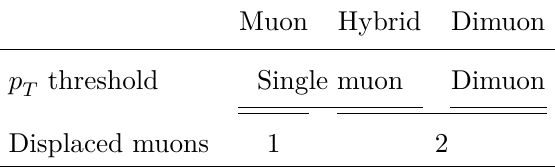
threshold is imposed on as well as the number T